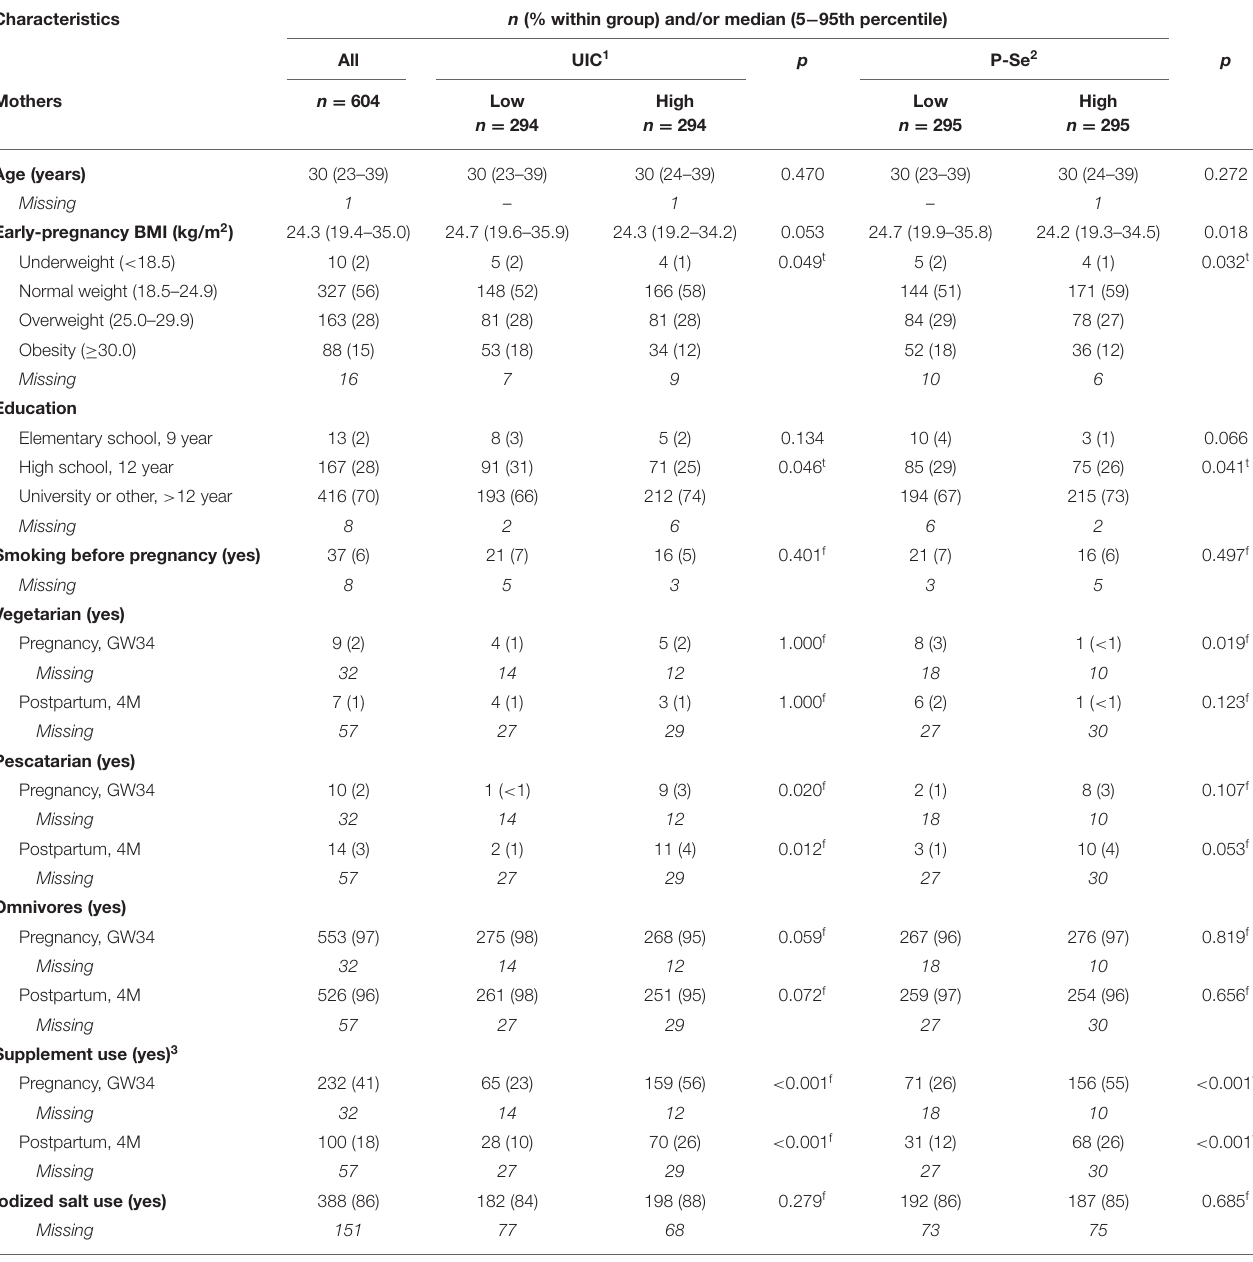
TABLE 1 | Characteristics of included mothers categorized by low and high (median split) iodine (urinary concentrations, UIC) and selenium (plasma concentrations, P-Se) status.